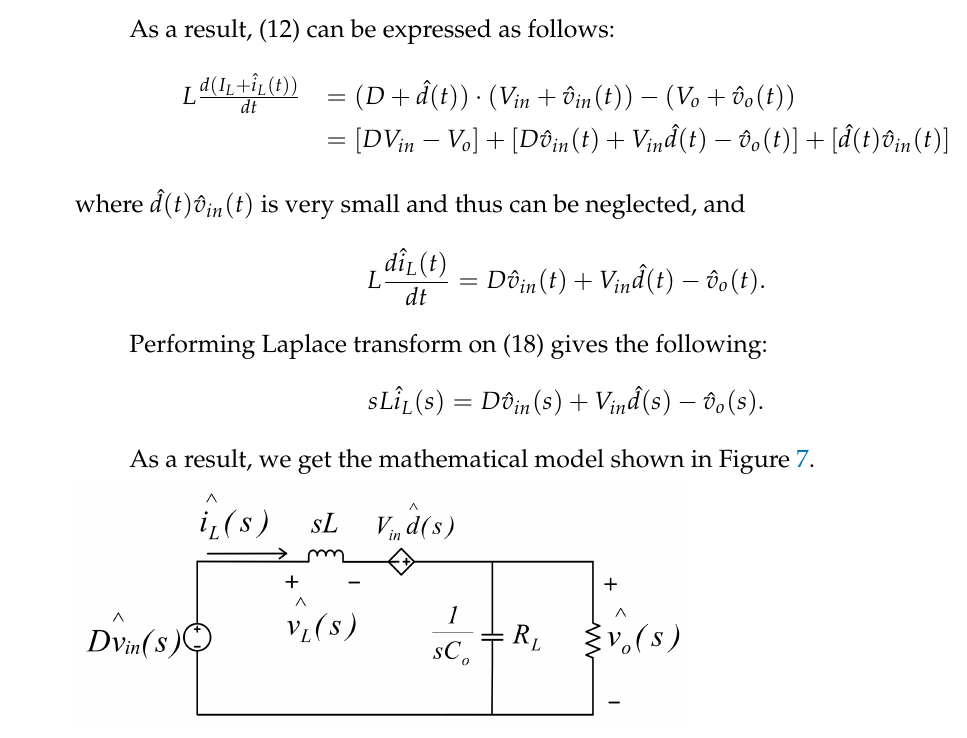
Figure 7. Mathematical model of synchronous buck converter.